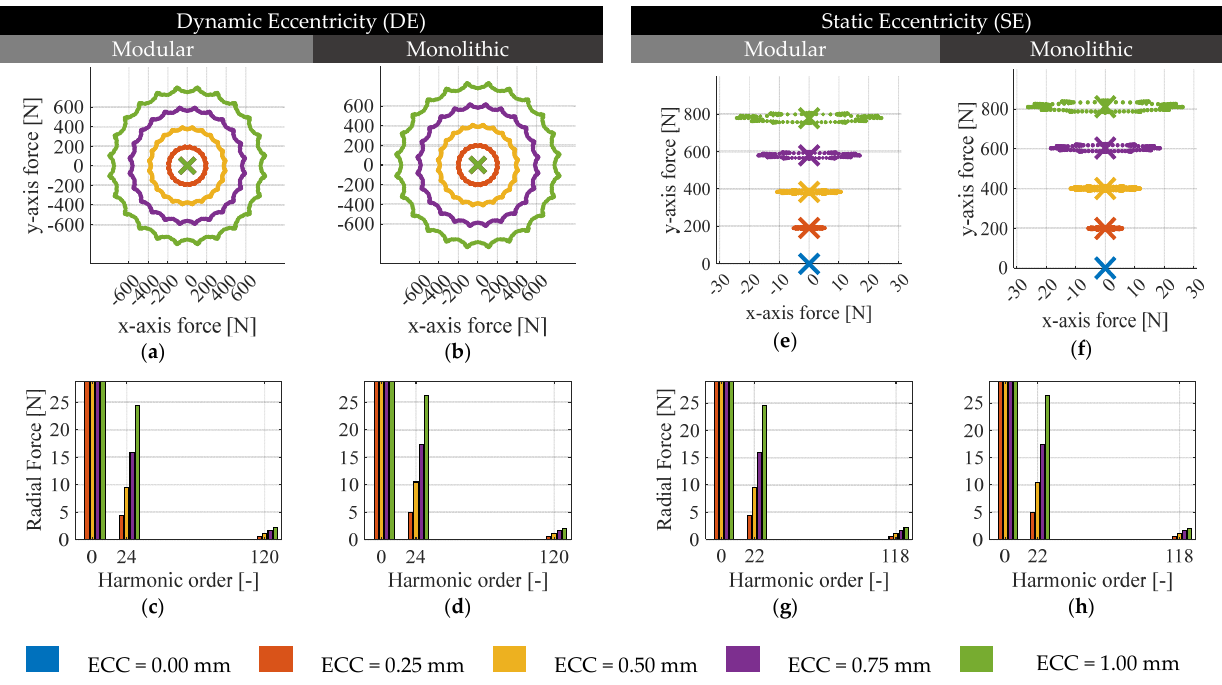
Figure 4. FE evaluation of radial forces acting on the rotor structure in the presence of DE (left column) and SE (right column) for a 24-slot, 22-pole PMSM and MPMSM: ( a ) x -axis and y -axis forces of DE on MPMSM, ( b ) x -axis and y -axis forces of DE on PMSM, ( c ) radial force spatial harmonic content of DE on MPMSM, ( d ) radial force spatial harmonic content of DE on PMSM, ( e ) x -axis and y -axis forces of SE on MPMSM, ( f ) x -axis and y -axis forces of SE on PMSM, ( g ) radial force spatial harmonic content of SE on MPMSM, ( h ) radial force spatial harmonic content of SE on